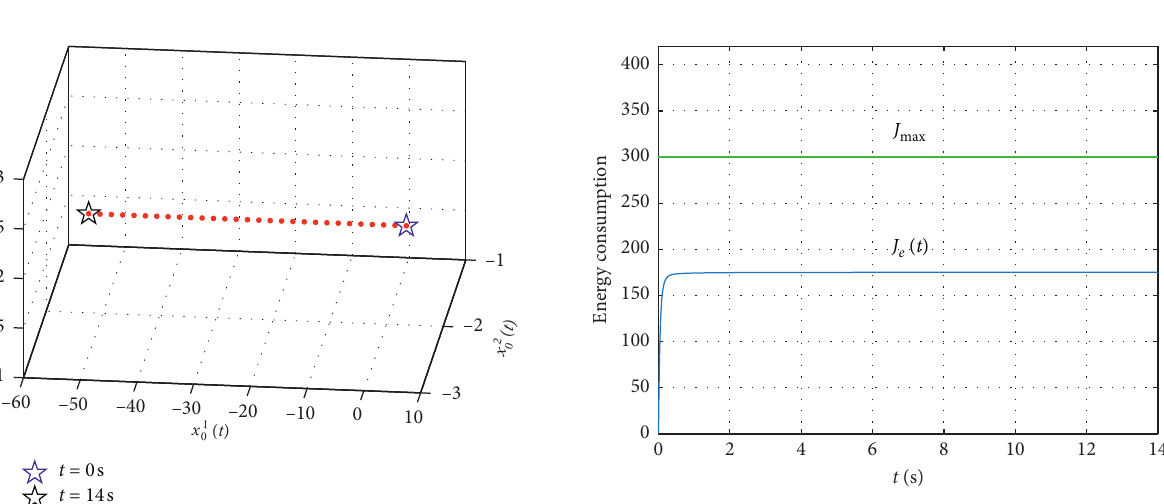
Figure 10: Energy consumption and the limited budget for time- invariant formation tracking